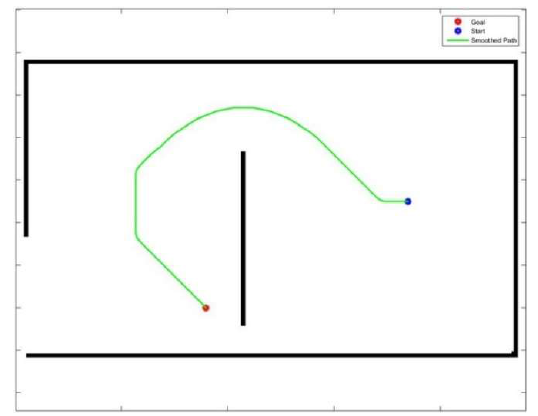
Figure 14. 2D representation of the generated path, for Dataset I, using the adjusted A* algorithm in a static environment.